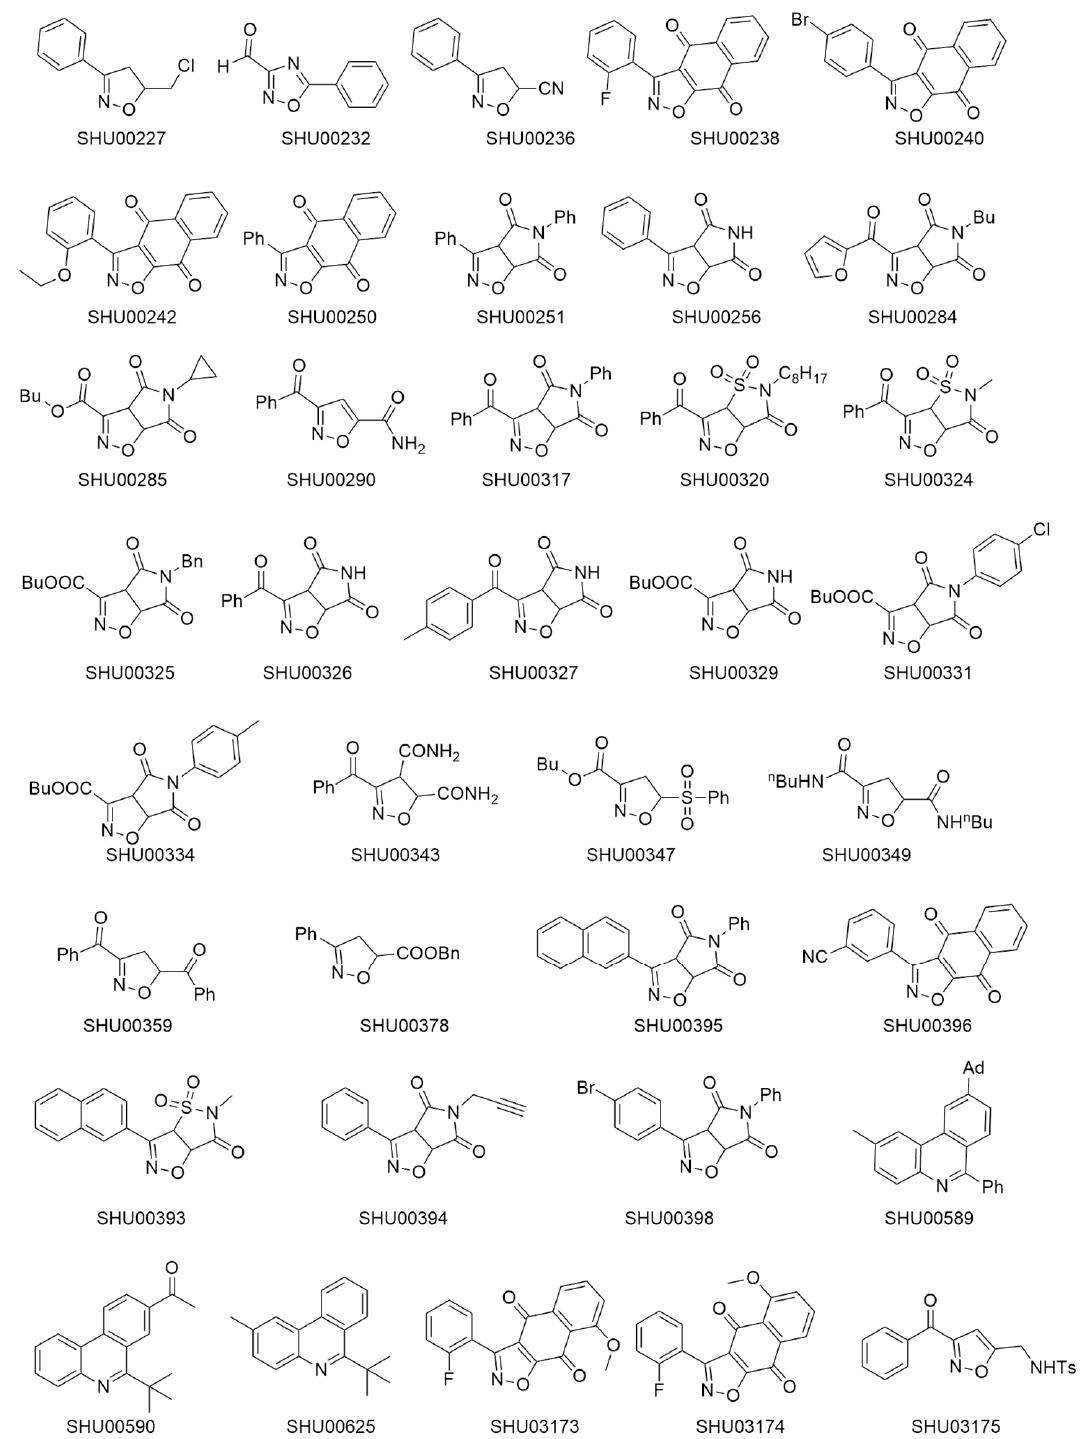
Figure 1. Chemical structure of 37 candidate compounds.